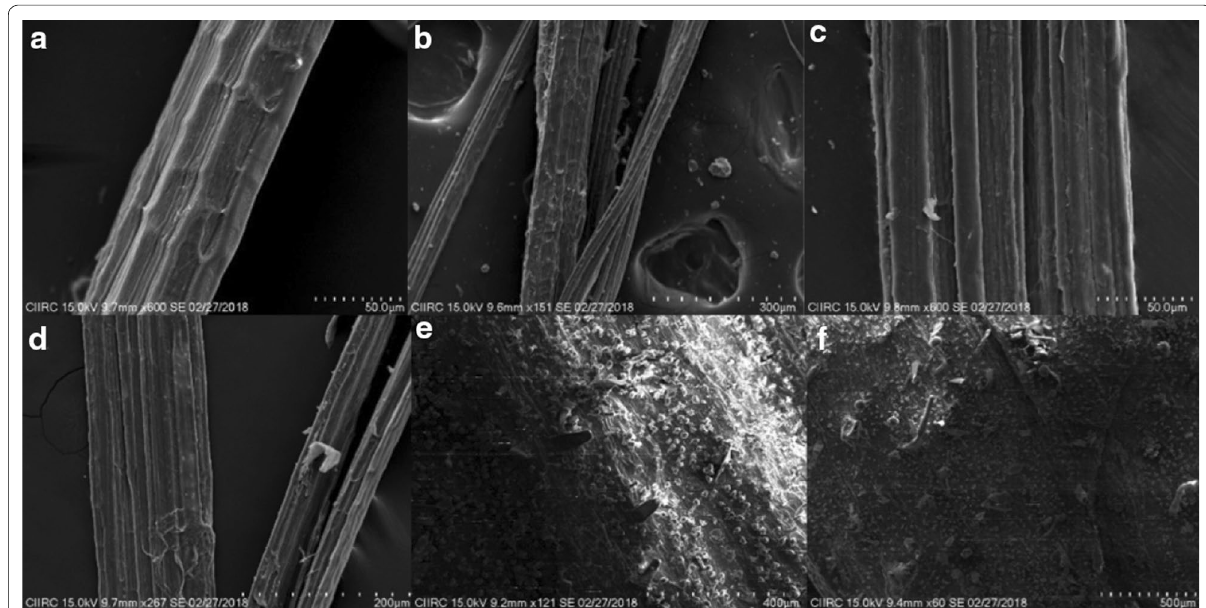
Fig. 1 Scanning electron microscope images of M. pinnata stalk and extracted fibers. a – d Surface features of the fibers, e – f surface features of the stalk